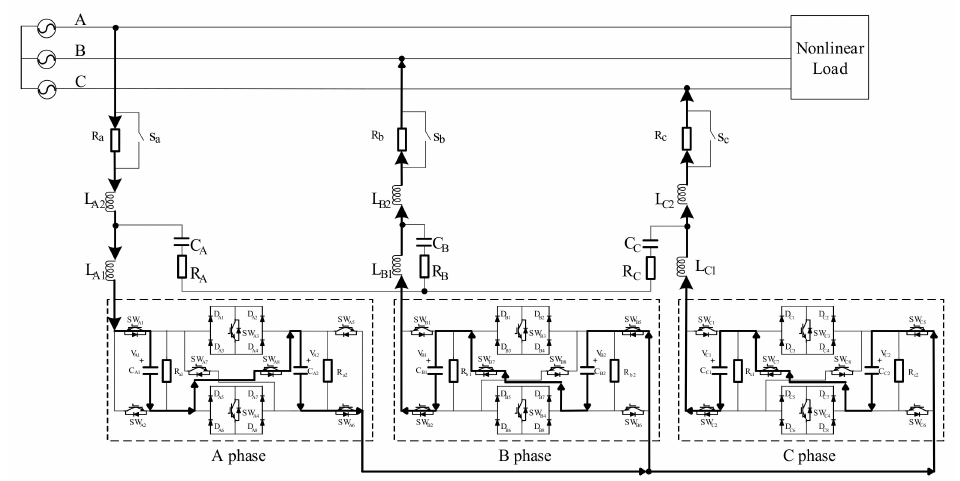
Figure 21. The start and stop process of the system.